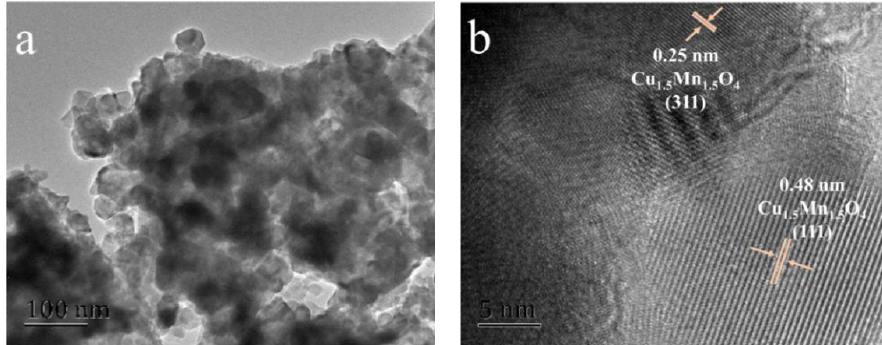
Figure 4. TEM image ( a ) and HRTEM image ( b ) of the Cu 1.5 Mn 1.5 O 4 sample.